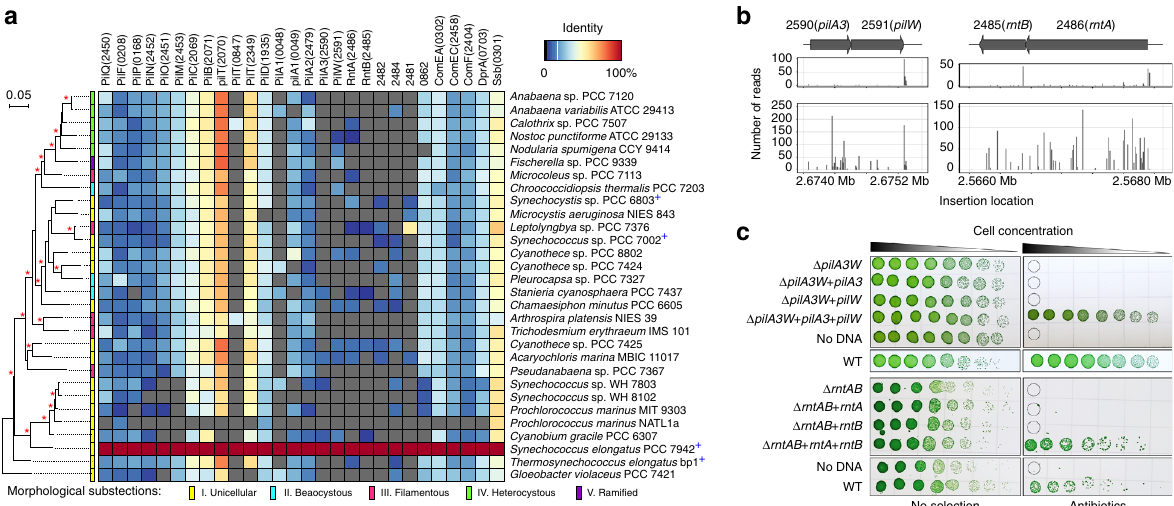
Fig. 2 The S. elongatus T4PM contains minor pilins required for natural competence. a Heatmap of protein sequence homologies between T4PM and competence proteins of S. elongatus and other strains of cyanobacteria. Gray cells indicate no homolog in the corresponding strain. Strains organized according to 16S rRNA gene phylogeny, inferred by Maximum Likelihood. Nodes supported by a bootstrap ≥ 70% ( n = 500) are marked with a red asterisk and strains that are known to be naturally competent are marked with a blue plus sign. b Genomic organization and RB-TnSeq insertion loci for two sets of genes essential for transformation. For each these coding regions and fl anking sequences, the number of sequencing reads for insertion-mutant barcodes in selective (top boxes) and non-selective control (bottom boxes) conditions is shown for one representative experiment. c Transformation assays performed on deletion and complemented strains of the pilA3 and pilW , and rntA and rntB loci. For each locus, both open reading frames were deleted then complemented separately and together. WT S. elongatus PCC 7942 served as a positive control and the fully complemented strains to which no DNA was added served as negative controls. The assays were performed with three independent clones for each strain and yielded identical results. Source data are provided as a Source Data fi